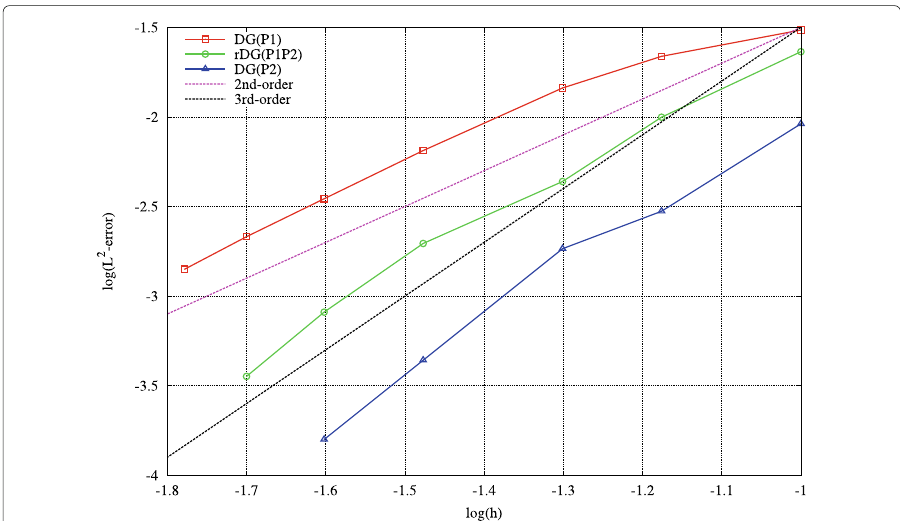
Fig. 5 Spatial convergence rates for DG(P1), rDG(P1P2) and DG(P2) discretizations of the isentropic vortex